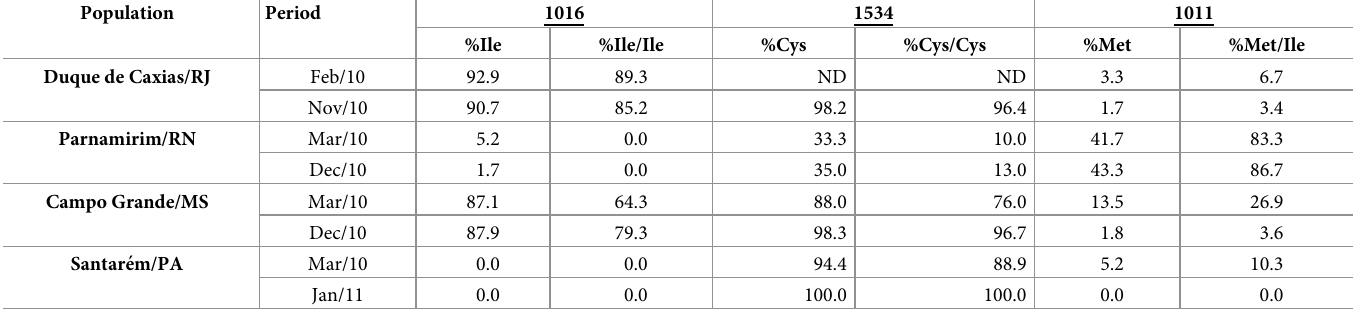
Table 2. Allelic and genotypic frequencies of specific Ae . aegypti Na V alleles at positions 1016, 1534 and 1011, shown separately, at the first and the last periods of field